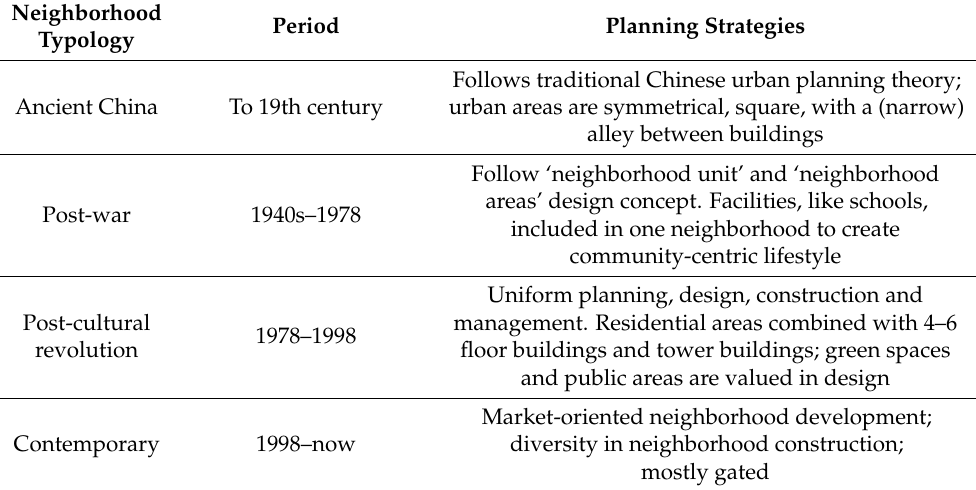
Table 2. Neighborhood typologies in